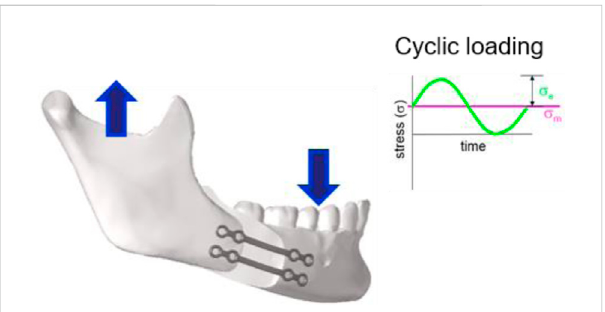
FIGURE 1 In-service loadingconditionoftheosteosynthesesplatesused in pairs. The arrows in the image illustrate the main components of the occlusal force. Cyclic loading is characterized by stress load cycles with a constant amplitude ( σ a ) and mean stress ( σ m